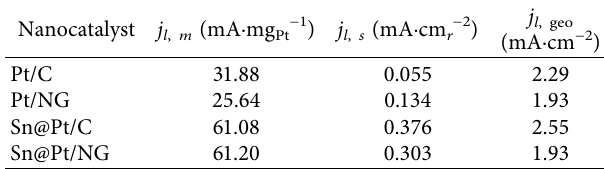
2 -saturated Table 4: Mass, specific, and geometric limiting currents of the HOR at 0.4V/RHE and 1600rpm on the